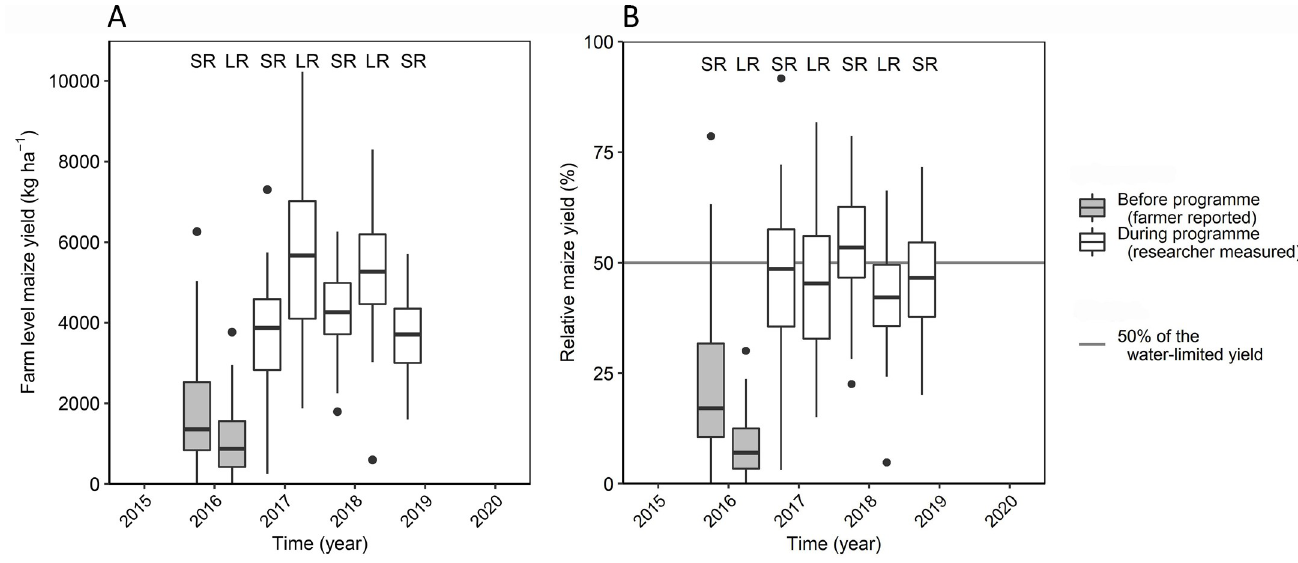
Fig 1. Farm-level maize yields in absolute values (A) and relative to the water-limited yield for the short (SR) and long rain (LR) cropping seasons (B) (n = 47 households with 1–8 maize fields per household). Yields before the programme were based on farmer-reported production and measured field sizes, while during the programme with the voucher available both were measured by researchers. The horizontal line indicates 50% of the water-limited yield. https://doi.org/10.1371/journal.pone.0283499.g001 level doubled in both locations. However, as maize area per farm also more than doubled in both locations, the increase in total N and P application did not nessesarily lead to a doubling of application rates. For instance, during the programme the N application rates in Vihiga were comparable to the rates applied before the programme.